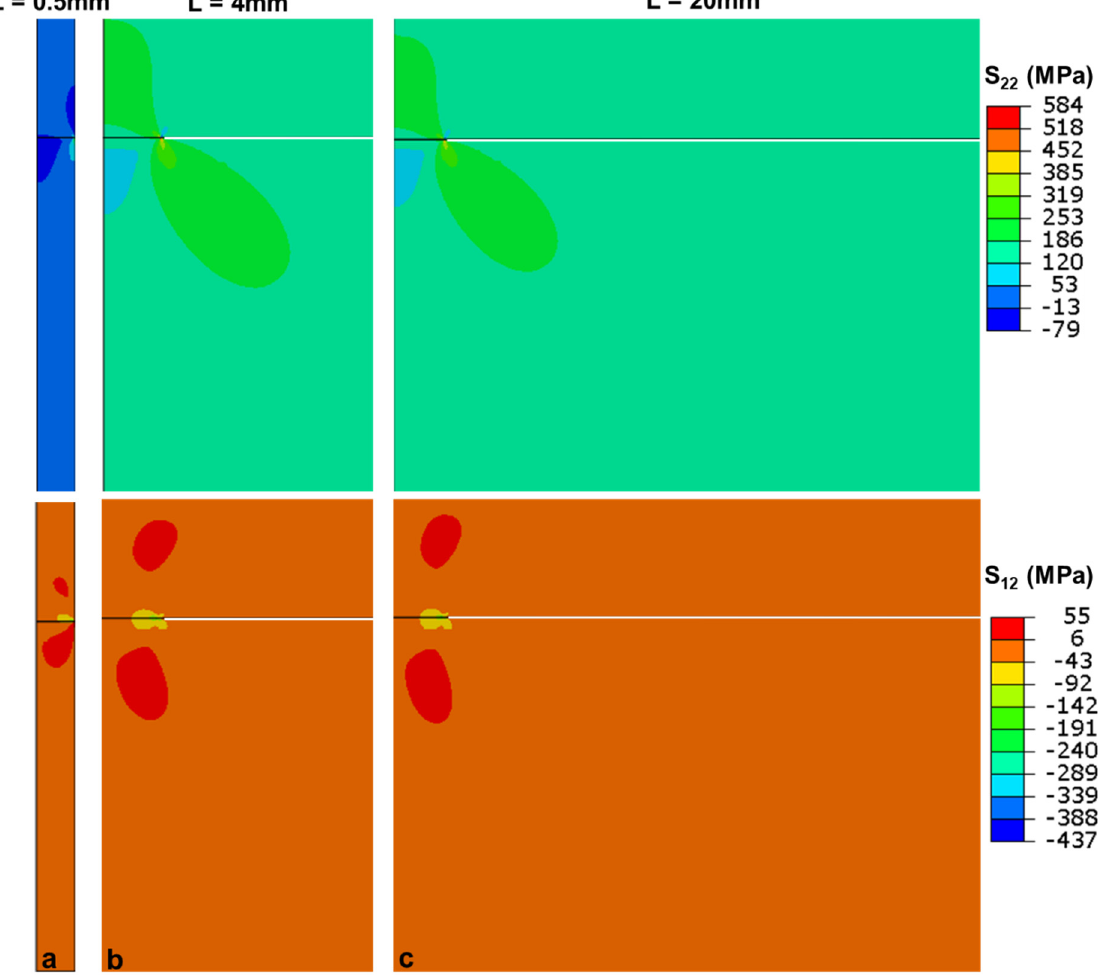
Figure 7. The crack propagation behavior for different cases of the SVC: ( a ) L = 0.5 mm, ( b ) L = 4 mm and ( c ) L = 20 mm.